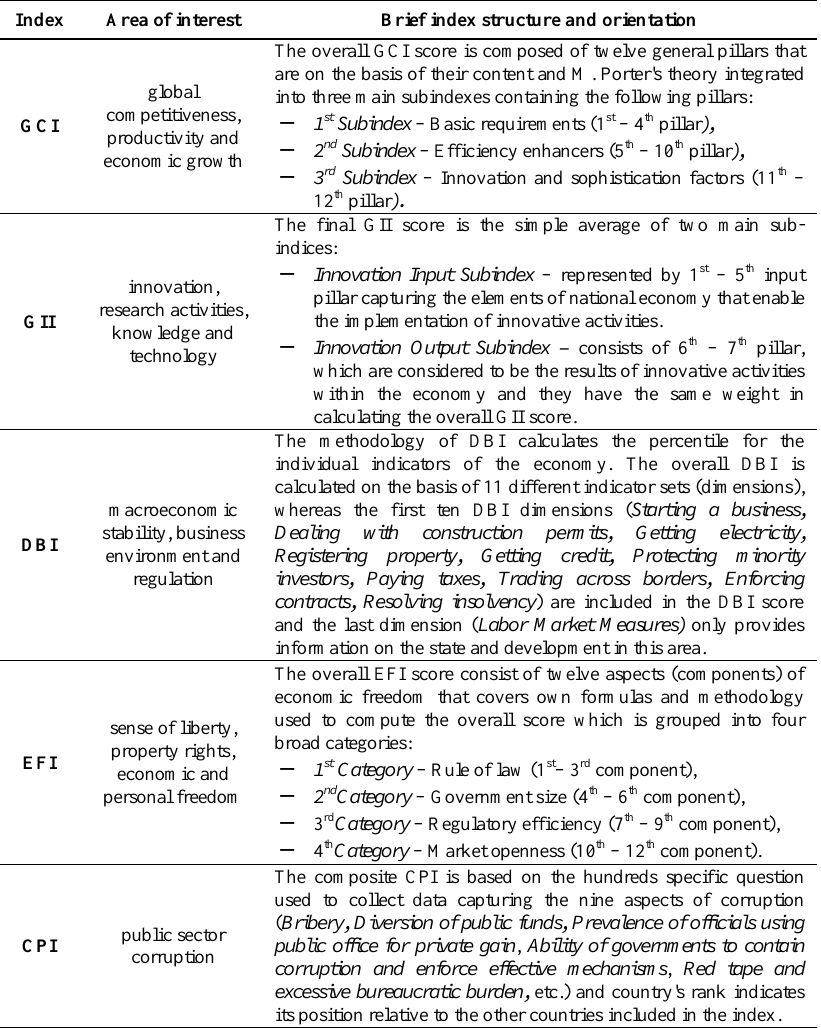
Table 1. Brief structure overview of the analysed